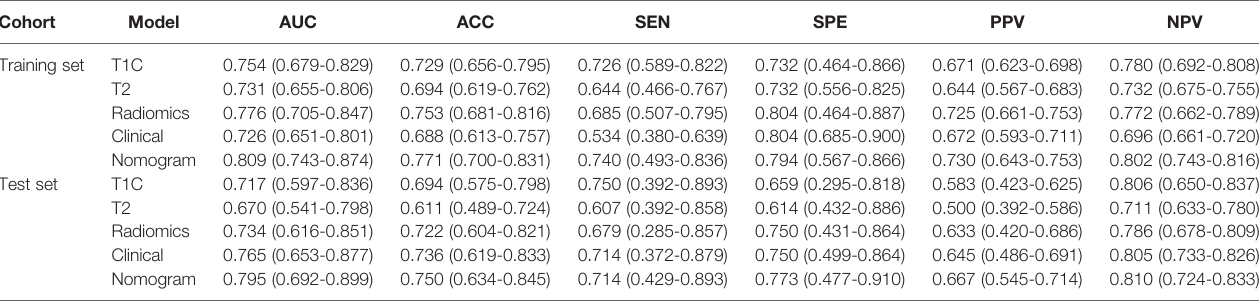
TABLE 2 | Performance of the sequence models. Cohort